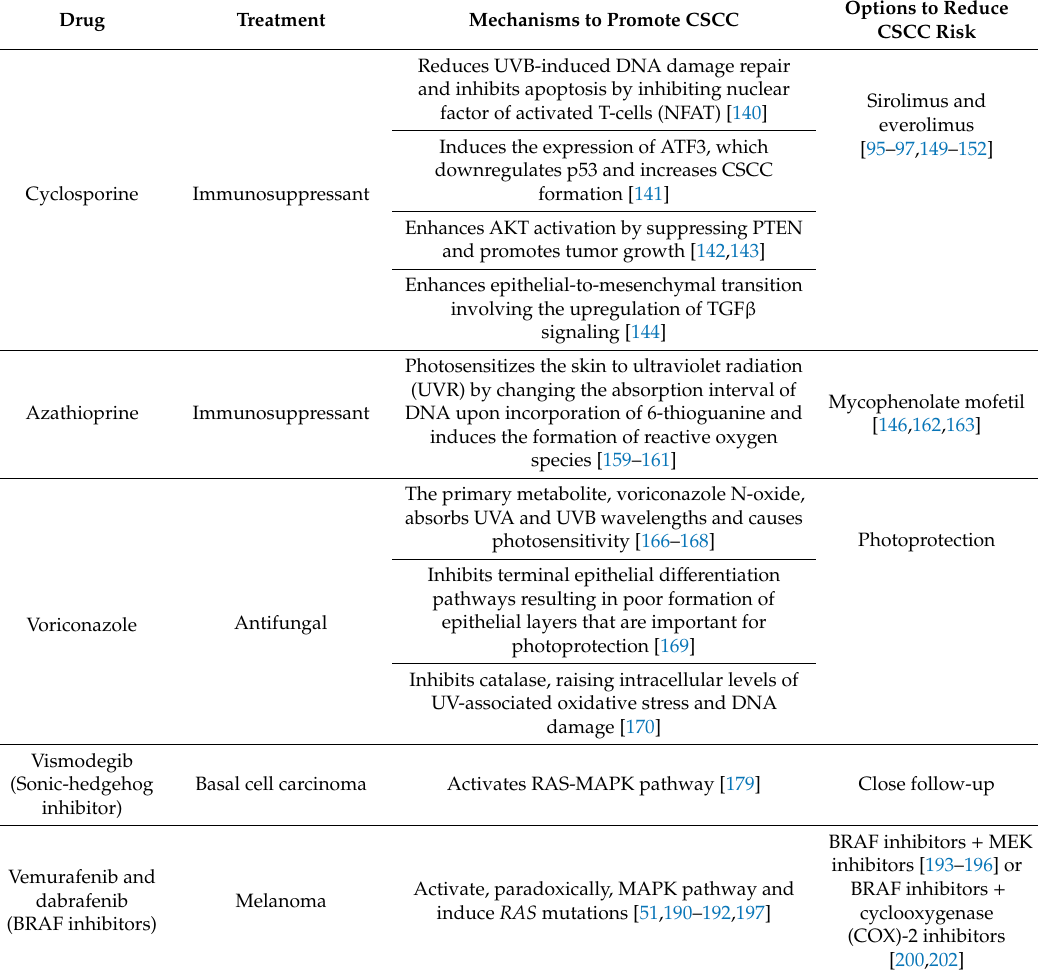
Table 3. Pharmacologically-induced